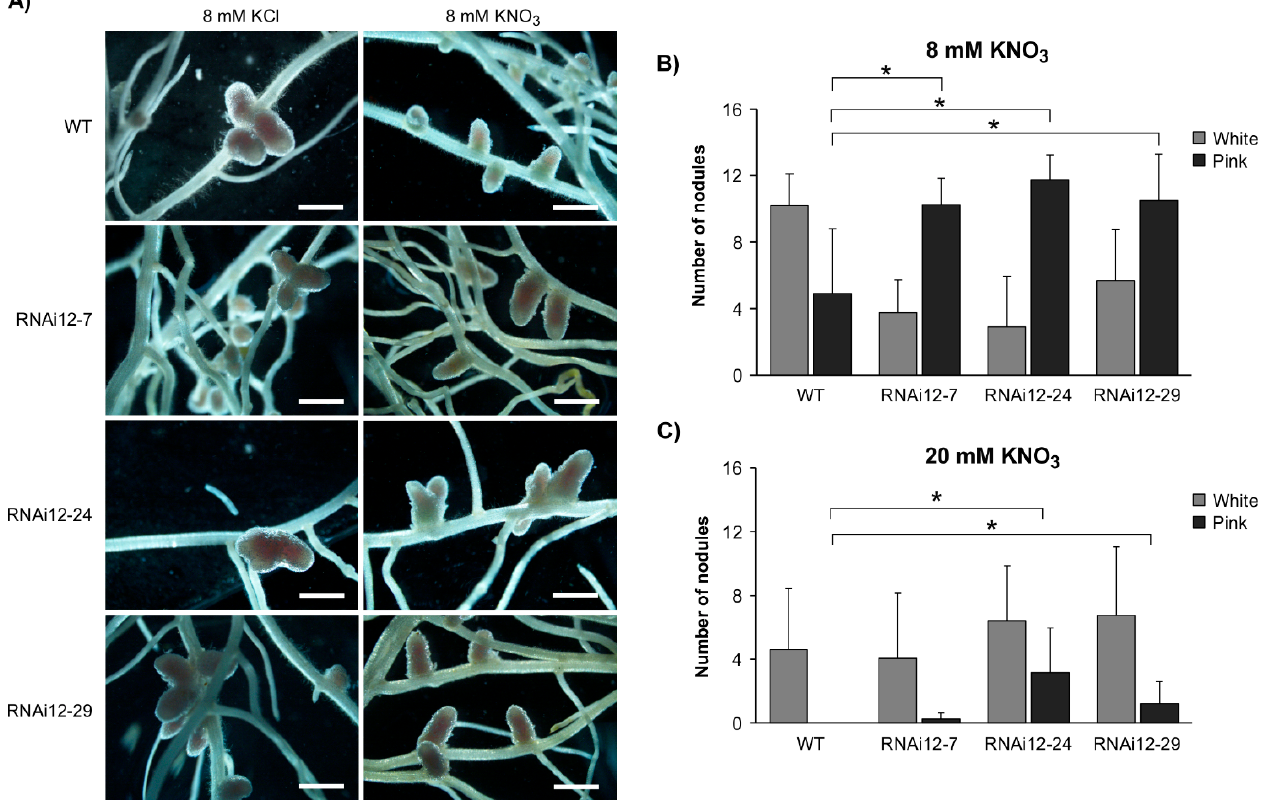
Figure 1. Effect of nitrate on nodule phenotype in SPL12 -RNAi plants. ( A ) Nodule phenotypes in WT and SPL12 -RNAi genotypes at 21 dai growing in nitrate-starved media and watered with 8 mM KCl or KNO 3 . Scale bars: 1 mm. The average numbers of pink and white nodules in WT and the SPL12 -RNAi at 21 dai under ( B ) 8 mM KNO 3 (n = 15–22 plants) and ( C ) 20 mM KNO 3 (n = 14–25 plants). * indicates significant differences relative to WT using Student’s t -test ( p < 0.05). Error bar indicates standard deviation.